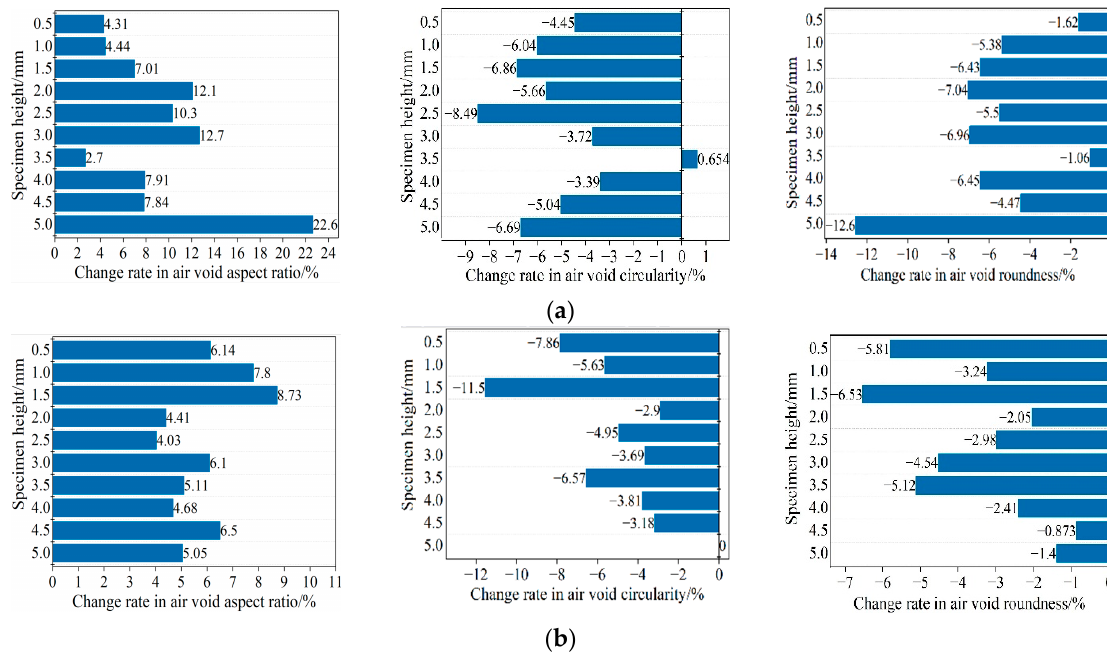
Figure 20. Variation of air-void shape characteristics in rutting test: ( a ) AC-13; ( b ) AC-16.